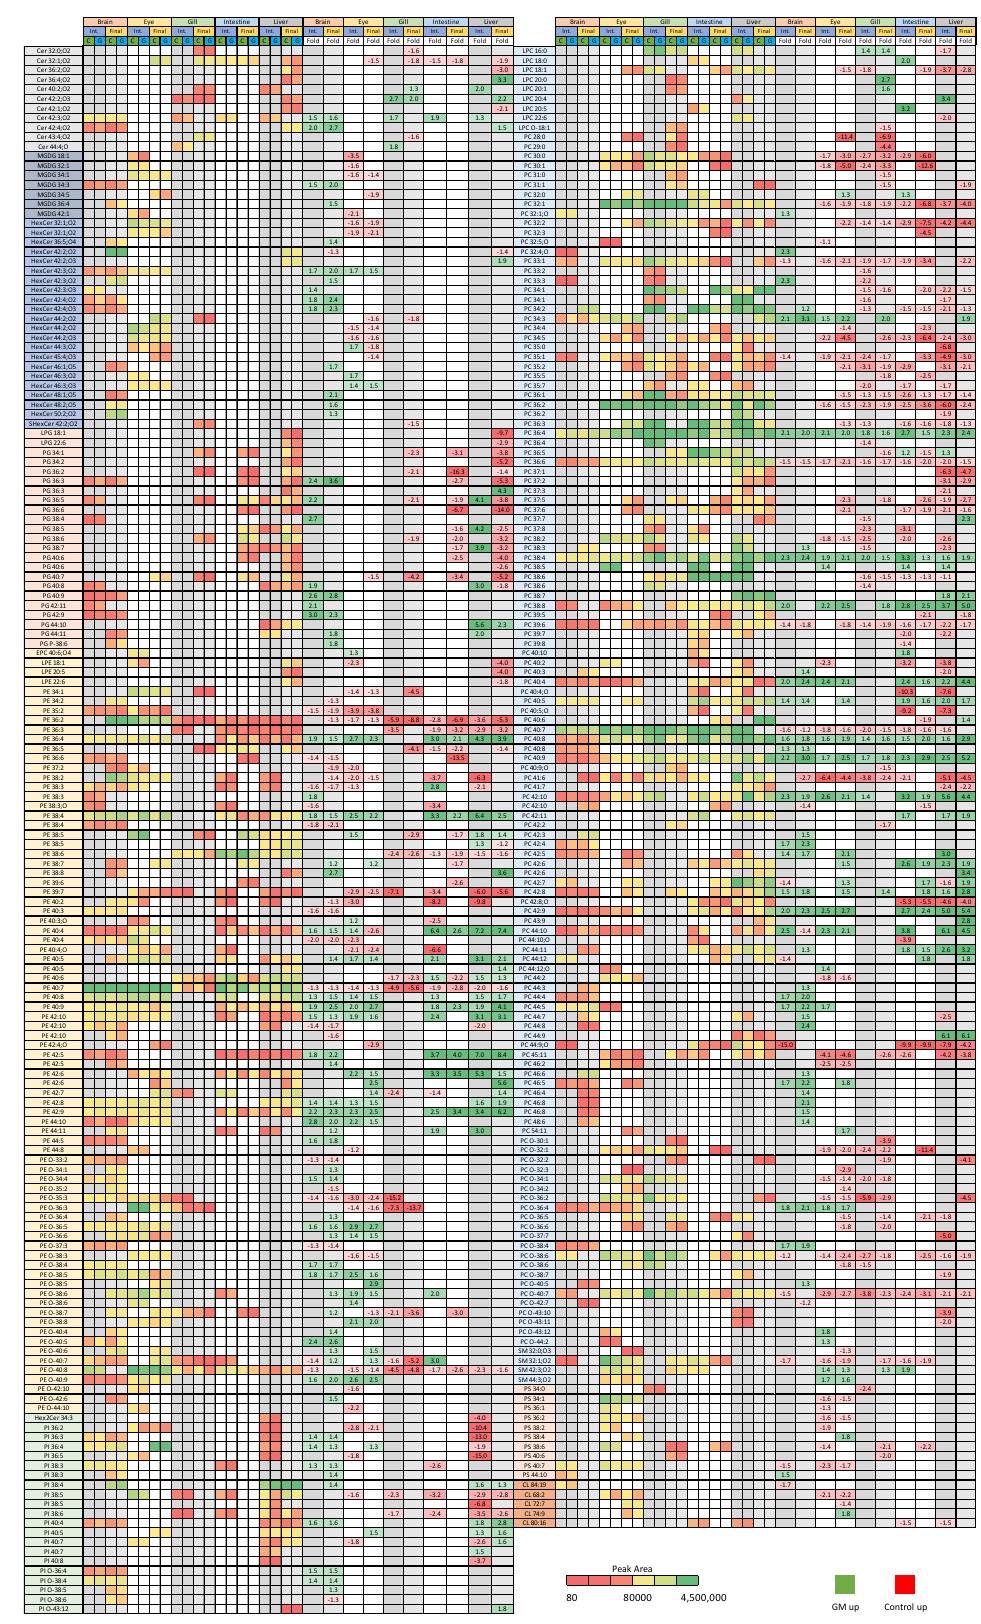
Figure 3. Lipids found to be significantly elevated by either the control or GM diet using the untargeted SFC-MS/MS methodology. Lipids were determined via ANOVA and OPLS-DA analysis and